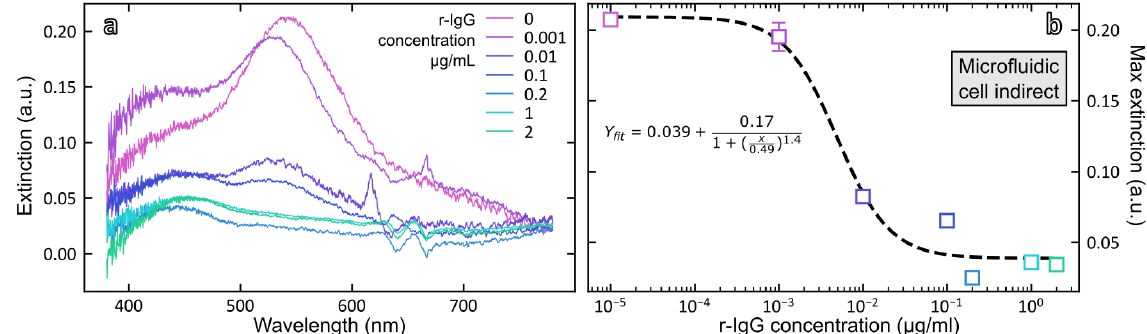
Figure 9. ( a ) Extinction spectra of the unbound fraction of AuNP-Ab after incubation of rabbit IgG in the range 0–2 µg/mL measured in the microfluidic cell; ( b ) Dose–response curve plotted from the maximum extinction at 530 nm vs. rabbit IgG concentration.